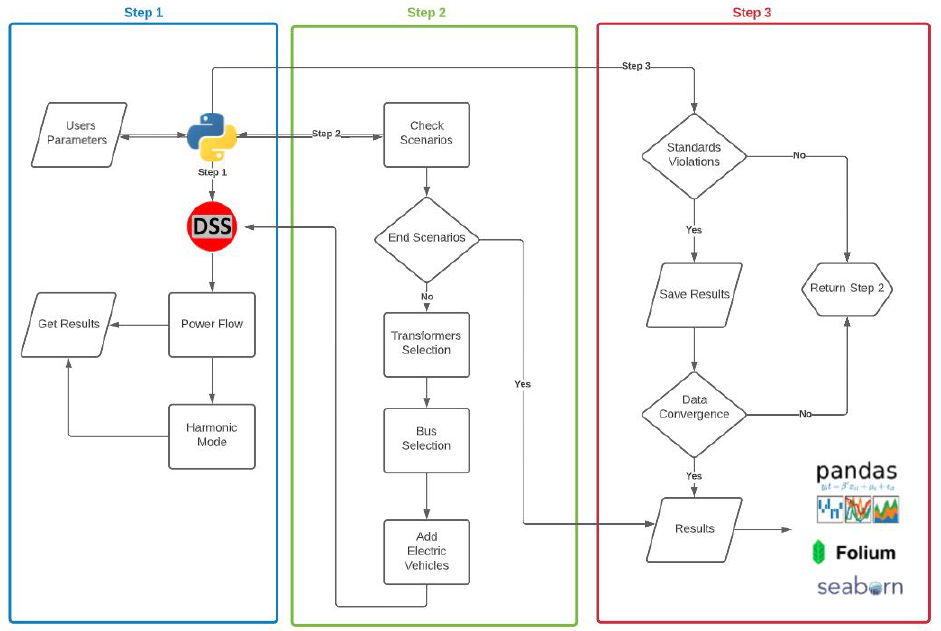
Figure 2. Low-voltage methodology